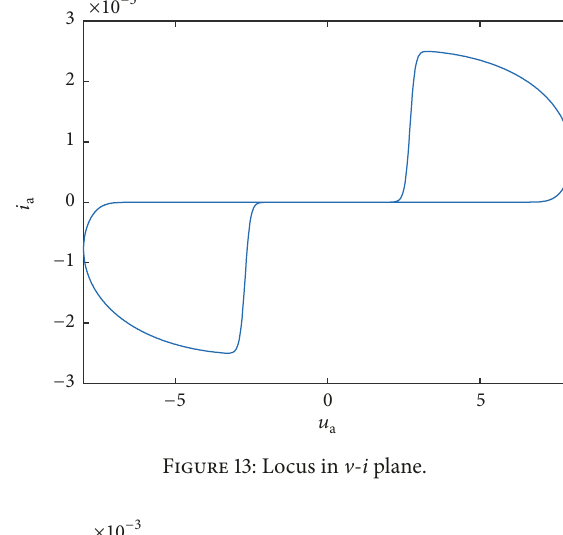
where 𝑢 𝑘 represents the voltage across the corresponding diodes VD 𝑘 . Considering 𝑢 3 = 𝑢 1 − 𝑢 a and substituting